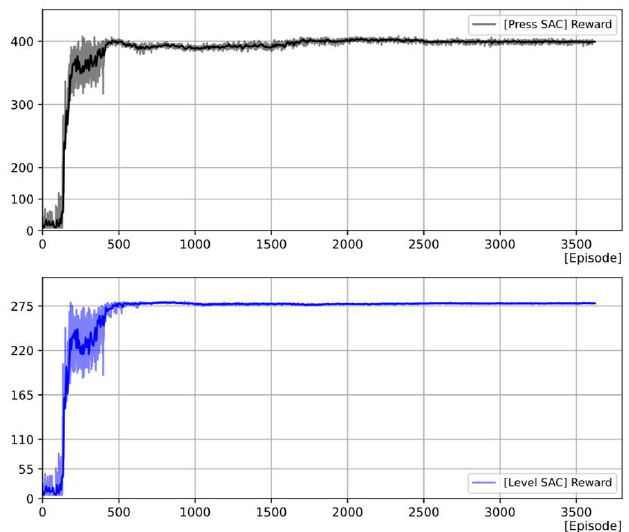
Figure 12. Average maximum probability per episode.